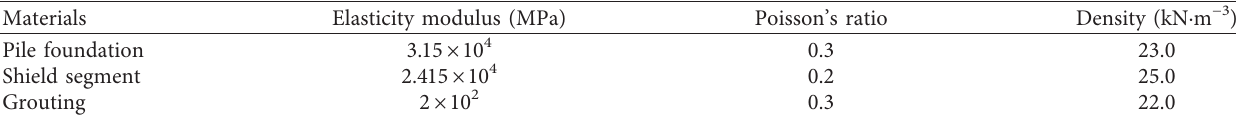
Table 2: Parameters of pile, segment, and grouting